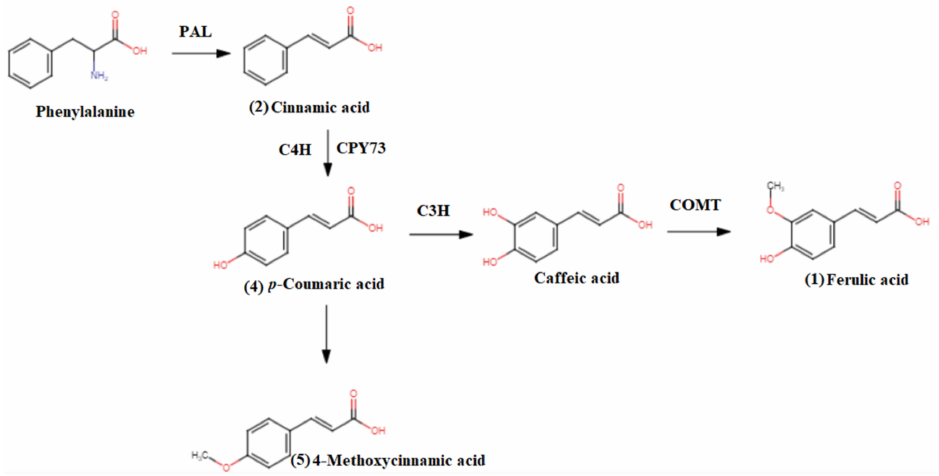
Figure 5. Biosynthetic pathways of cinnamic